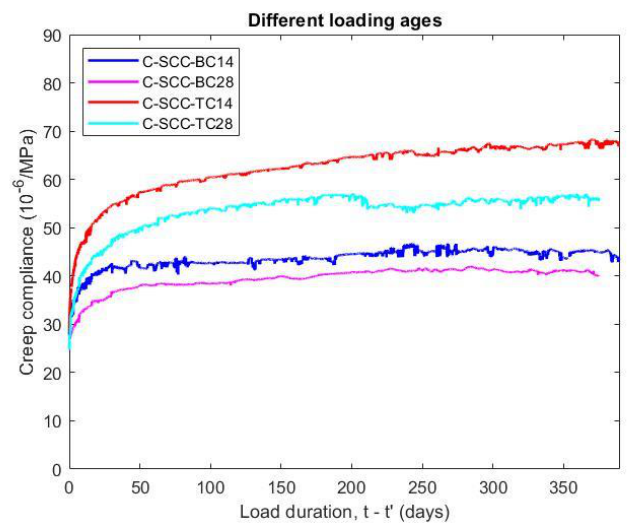
Figure 8. Effect of loading ages on basic and total creep compliance of SCC specimens.